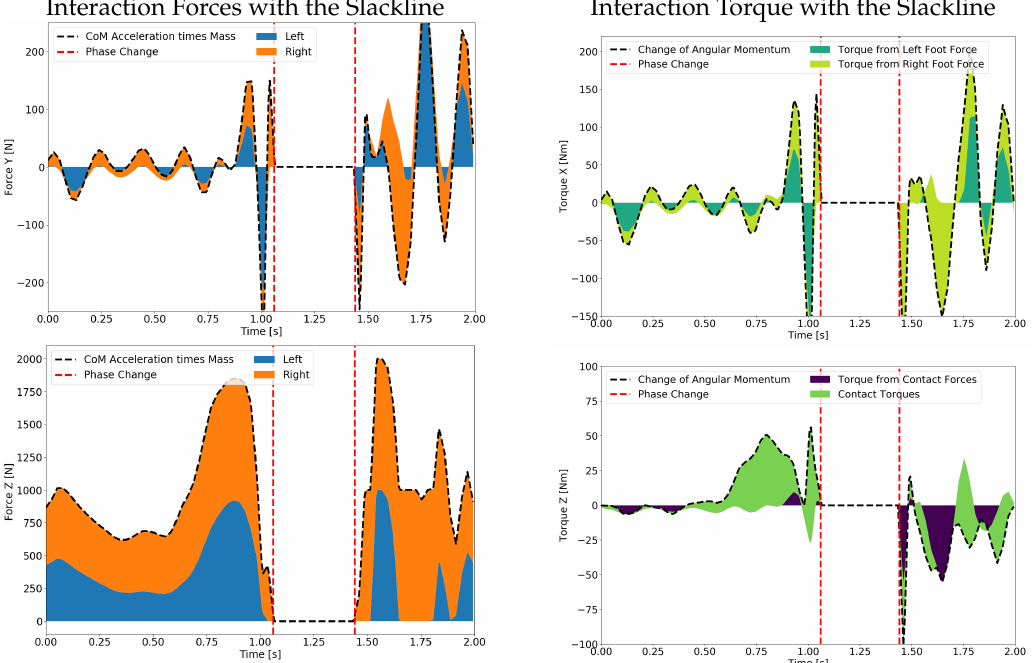
Figure 9. Left: Sum of contact forces and Center of Mass acceleration times subject mass. Right: Sum of contact torques and torques produced by the contact forces plotted against the change of angular momentum. Equations (11) and (12) are satisfied throughout the